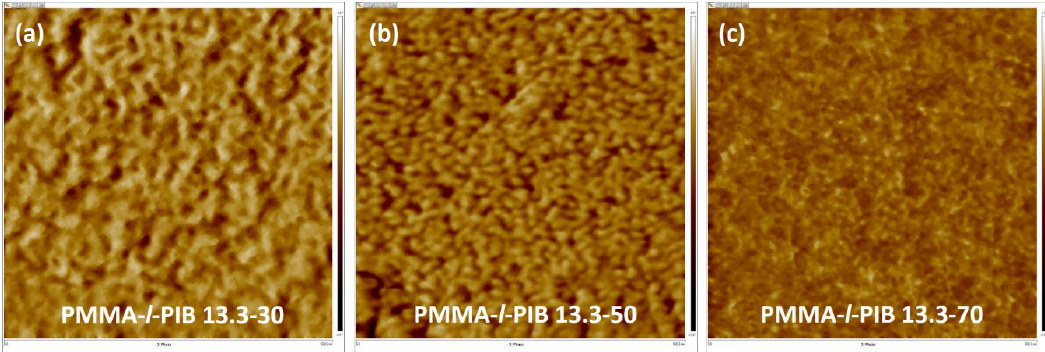
Figure 4. Atomic force microscopy (AFM) phase mode images of the cross-section of the PMMA- l- PIB-13.3 conetwork series (bright phases: PMMA, dark phases: PIB; picture dimensions: 500 nm × 500 nm); ( a ) PMMA -l- PIB 13.3-30, ( b ) PMMA -l- PIB 13.3-50, and ( c ) PMMA -l- PIB 13.3-70).